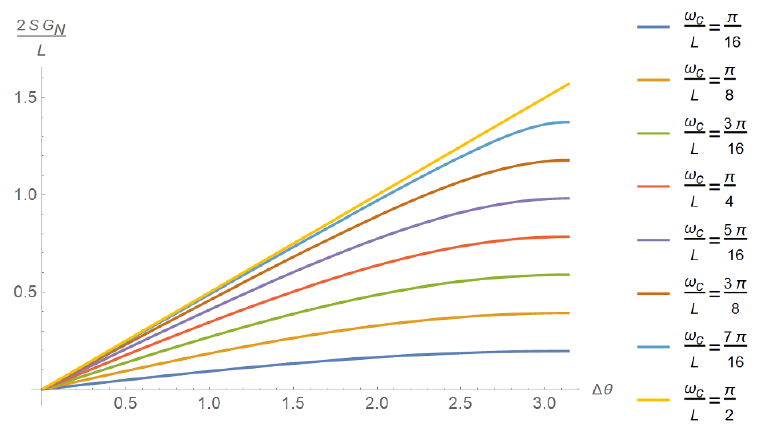
Figure 1 . The Scaling Behavior of